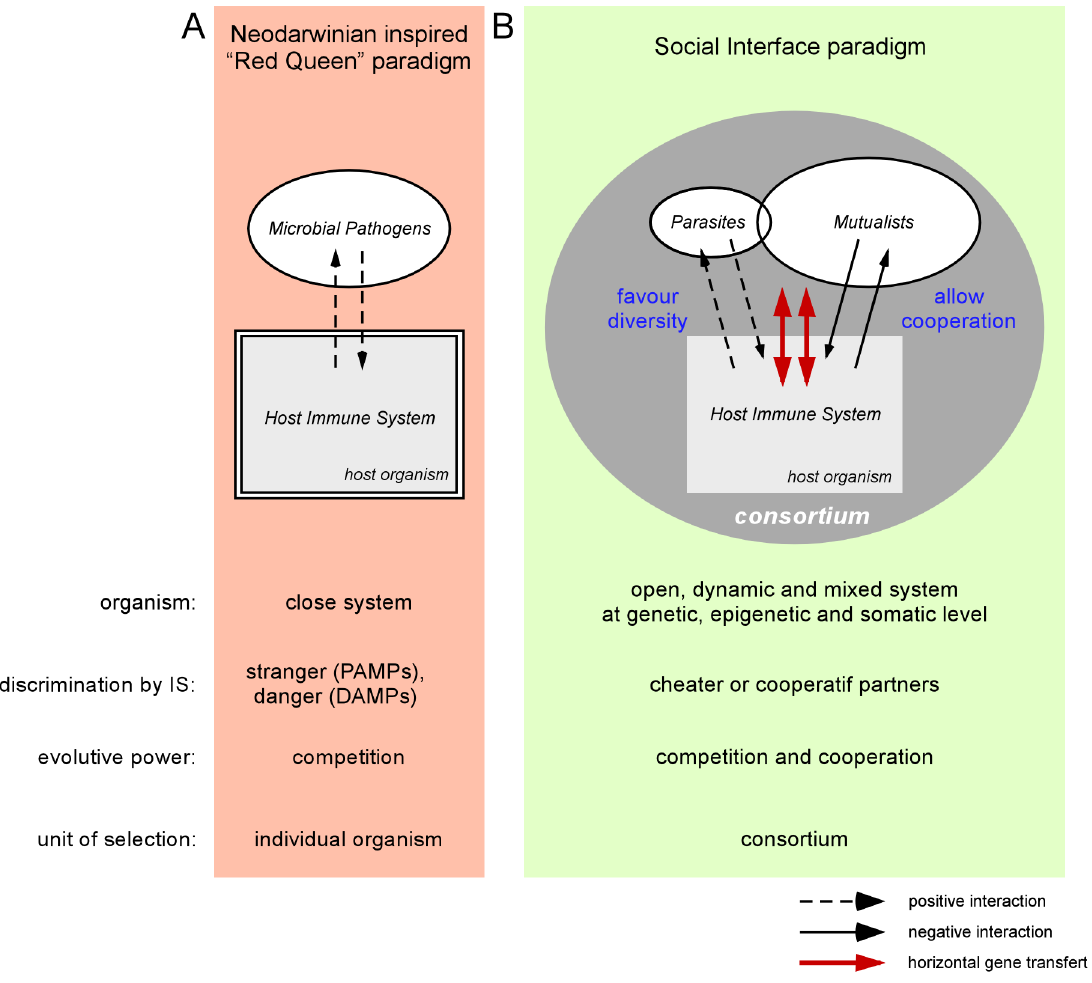
Figure 1. The relationship between the metazoan immune system and the microbial world. A. In the neo-Darwinian–inspired Red Queen paradigm, the immune system (IS) fights microbial pathogens and protects the integrity of the host organism. Pathogens are identified by the presence of PAMPs and DAMPs. B. In the social interface paradigm, the IS allows for the establishment of a symbiotic relationship between the host and parasites and the microbiota. Discrimination is based on a cheater or cooperative profile. In this new paradigm, the organism loses its unicity and strict boundaries and becomes an open, dynamic, and mixed consortium.